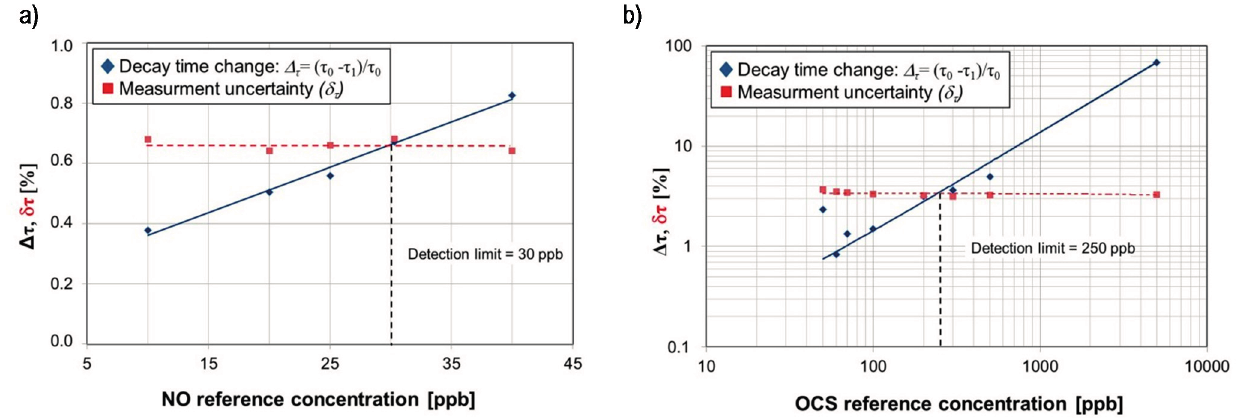
Figure 6. ( a ) The decay time changes of radiation in the optical cavity filled with reference concentration of NO ( b ) and OCS registered in the CEAS setup equipped with the tested